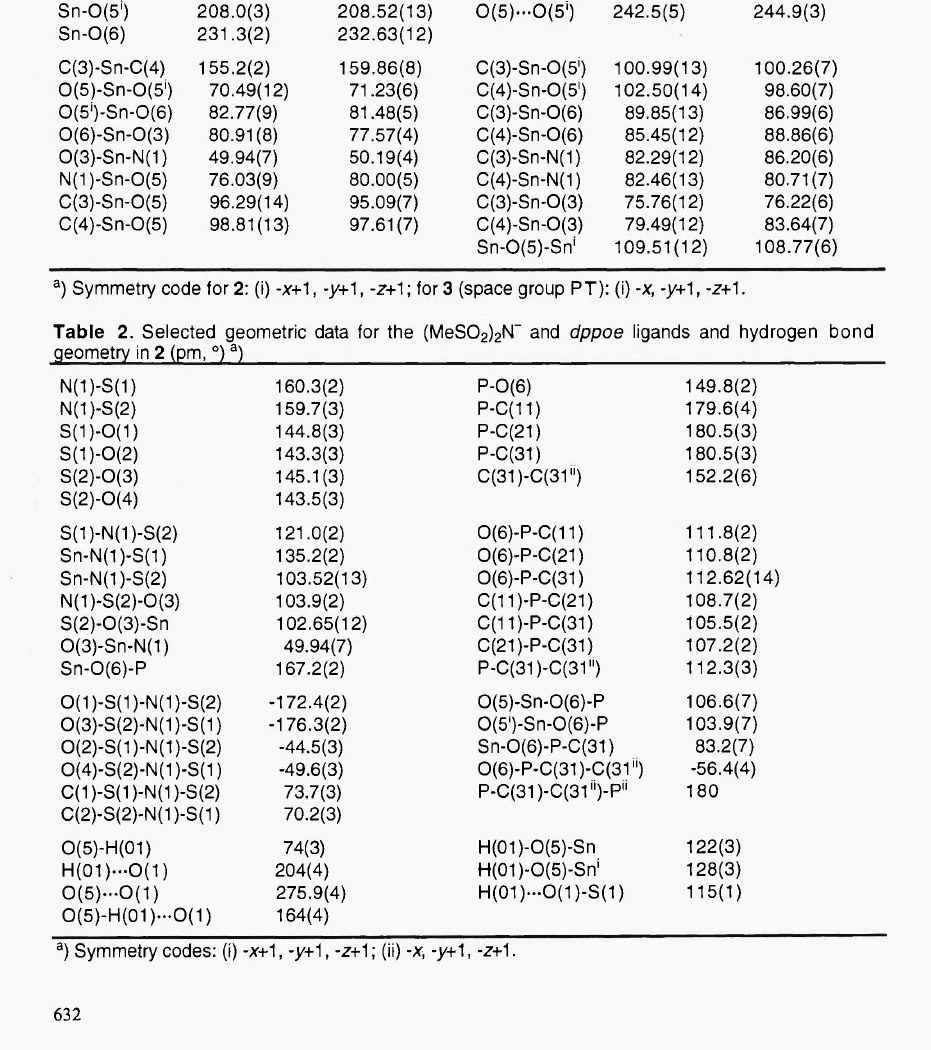
Table 1. Coordination polyhedron of the tin atoms and geometries of the [SnO(H)] 2 rings in 2 and 3(pm. V) 2